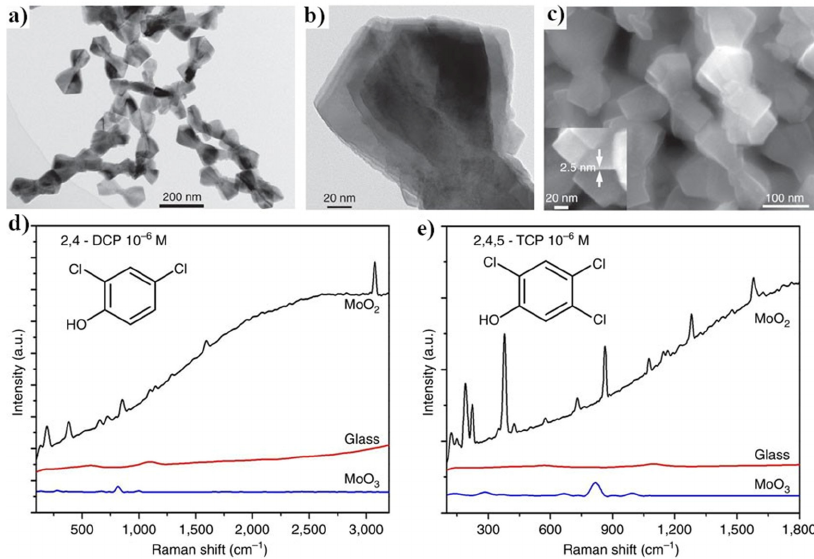
Figure 13. ( a , b ) TEM images of the MoO 2 nanocrystals, ( c ) SEM image of the MoO 2 nanocrystals, ( d , e ) SERS spectra of polychlorinated phenols adsorbed on the surface of MoO 2 . Reprinted with permission from [70].